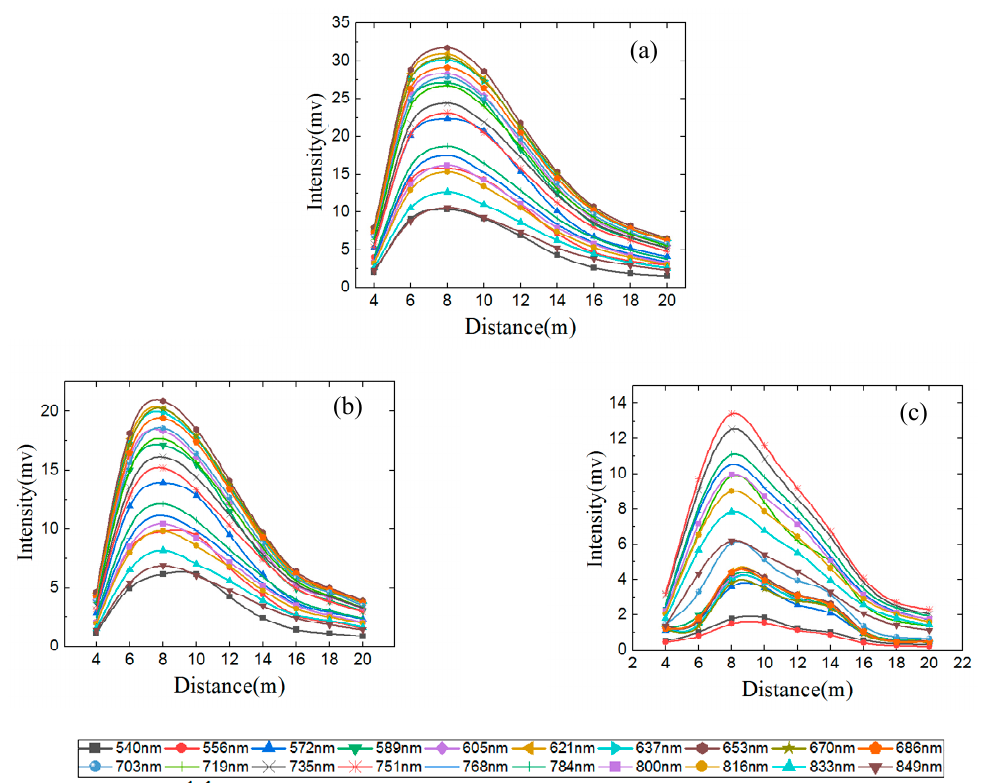
Figure 8. Backscatter intensities of twenty wavelengths versus distance. ( a ) Raw intensities of the 99% standard reflectance panel versus distance. ( b ) Raw intensities of 50% standard reflectance panel versus distance. ( c ) Raw intensities of a leaf sample versus distance.